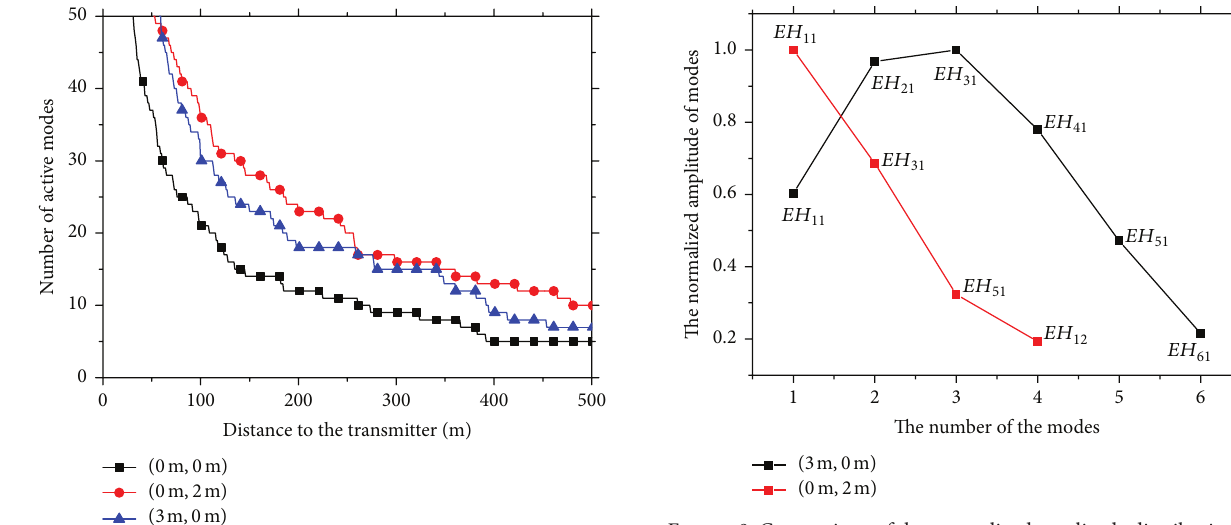
Figure 8: Comparison of the number of active modes tested with different antenna locations using the proposed modal method.